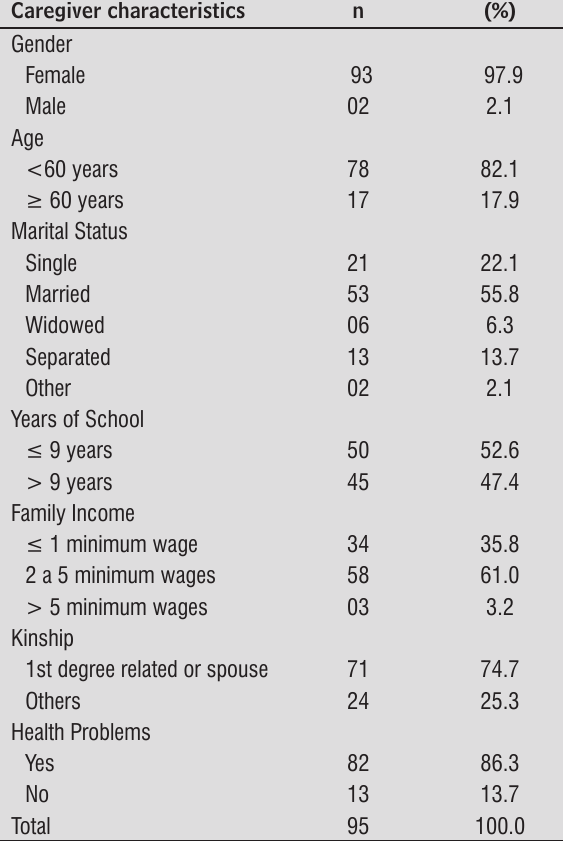
Table 2 - Characteristics of caregivers, Home Care Service in relation to caregiving